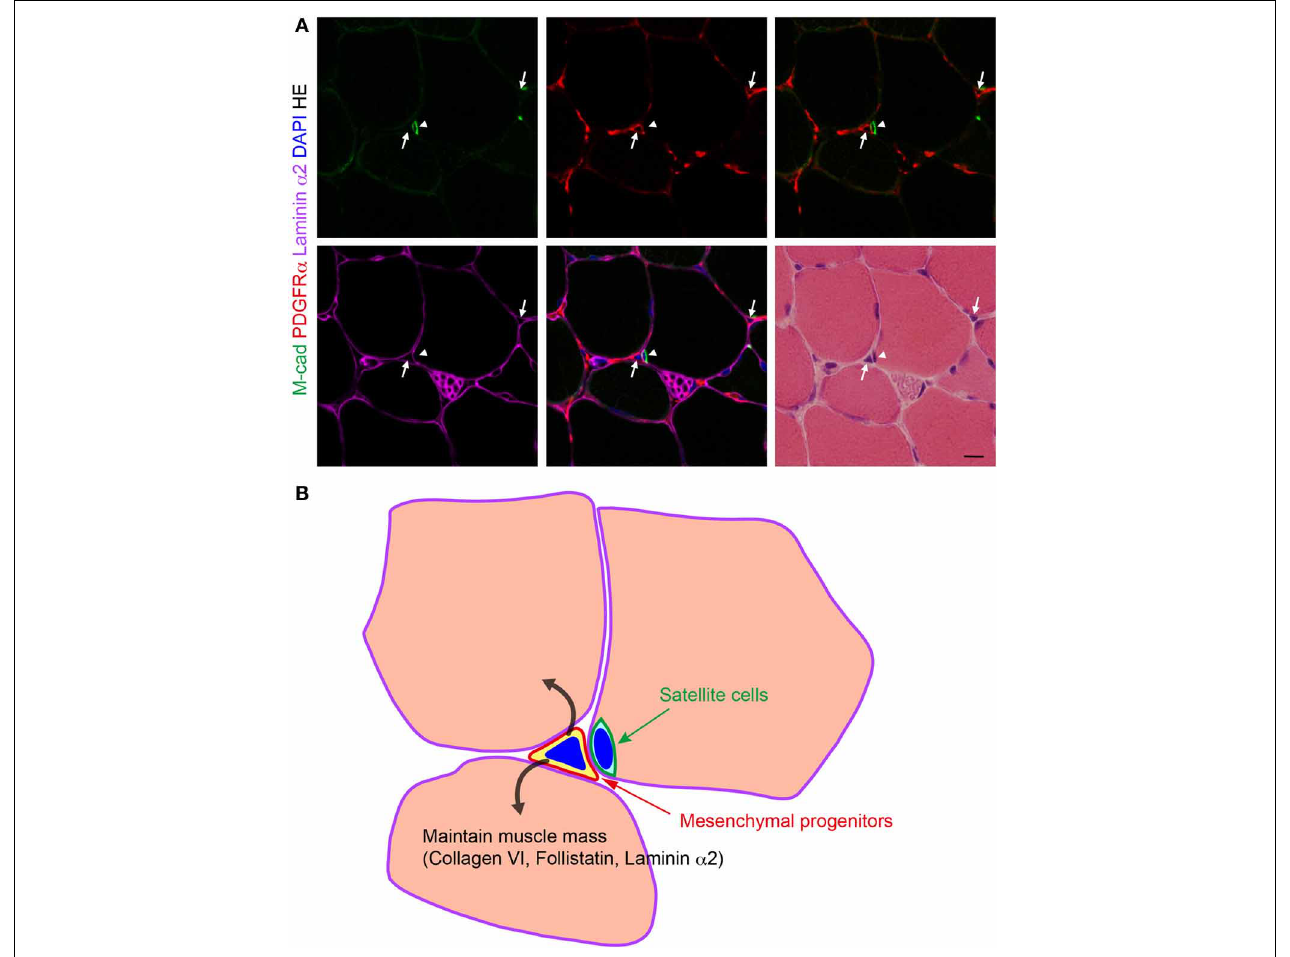
FIGURE 1 | Localization of PDGFR α + mesenchymal progenitors in normal muscle. (A) Fresh frozen section of mouse TA muscle subjected to immunofluorescence staining for M-cadherin (M-cad), PDGFR α , and laminin α 2, and subsequently to HE staining. Arrows indicate PDGFR α +